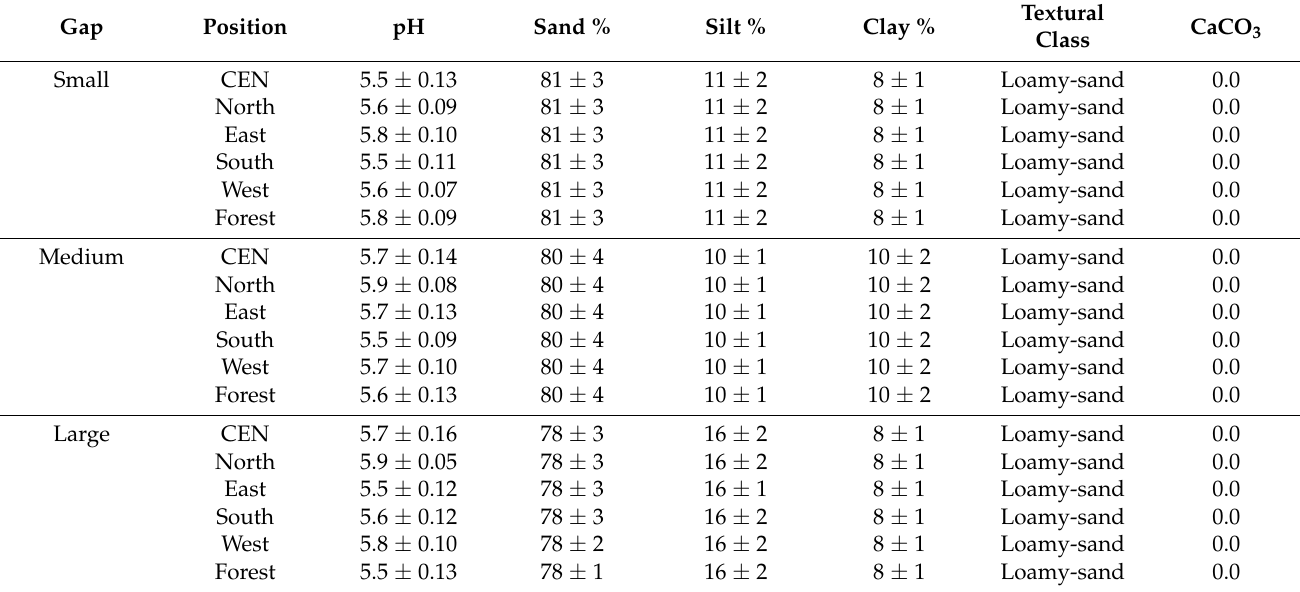
Table 1. Chemical characteristics of soils in each gap size for each cardinal points, in center of gap (CEN) and in forest. Gap